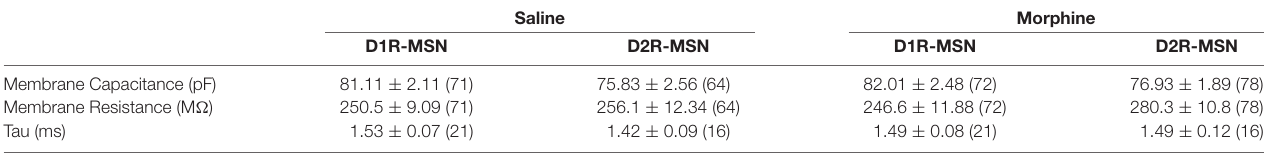
TABLE 1 | Cell Properties from electrophysiological